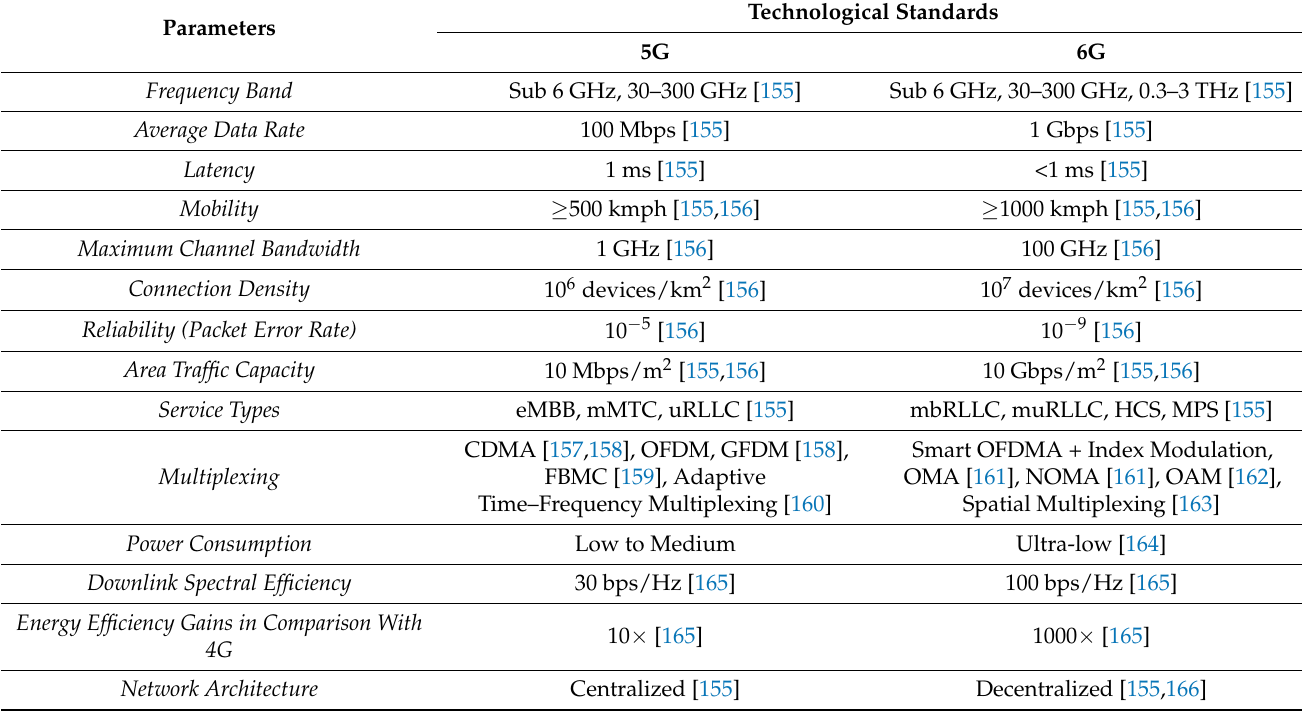
Table 5. A comparative analysis between 5G and